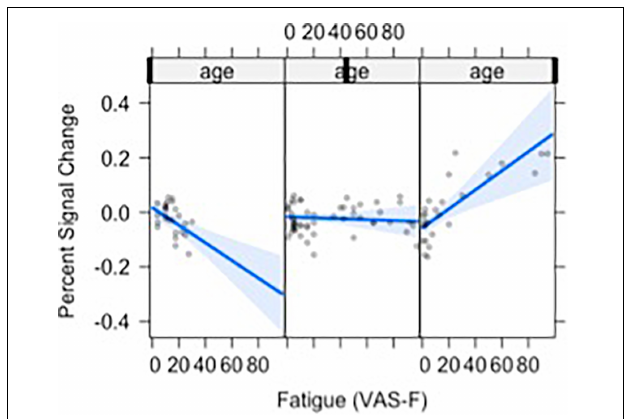
FIGURE 3 | The relationship between visual analog scale of fatigue (VAS-F) and Age in the middle frontal gyrus is shown. For this plot, the age range was divided into three sections: 20–32, 33–48, 49+. This division is for exposition only and does not reflect subgrouping in the analyses of the data (age was a continuous variable in all analyses). The blue line represents the best fitting linear relationship between VAS-F and age. The 95% confidence interval around this line is plotted in lighter blue. The data are represented by gray